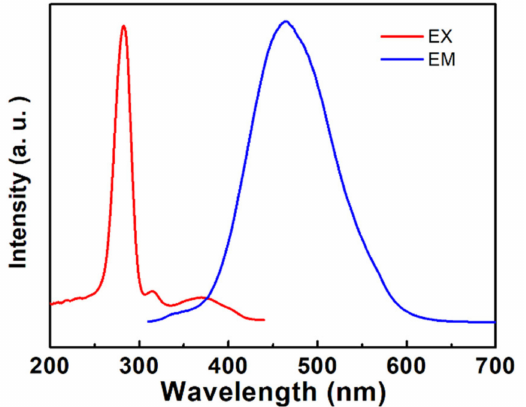
Figure 8. The room temperature excitation spectra with λ em = 465 nm and emission spectra of CaNb 2 O 6 crystal with λ ex = 282